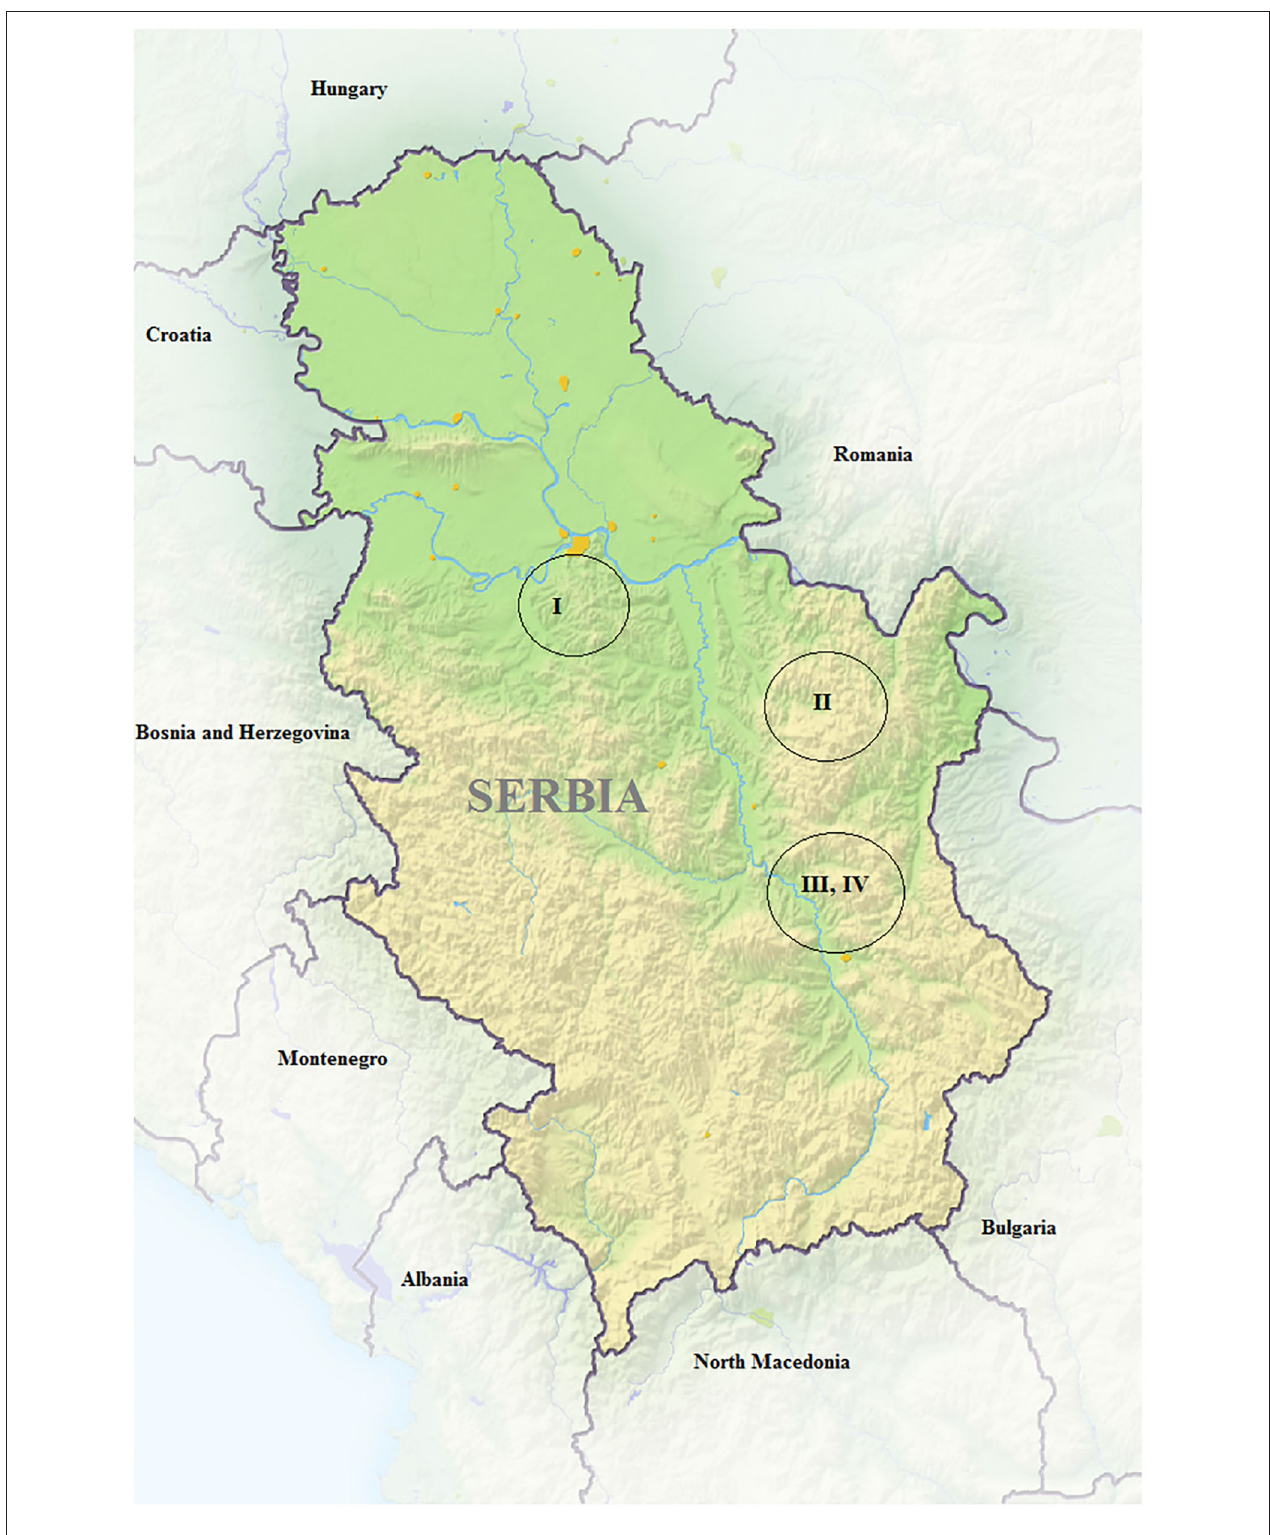
FIGURE 2 | Geographic position of farms included in the